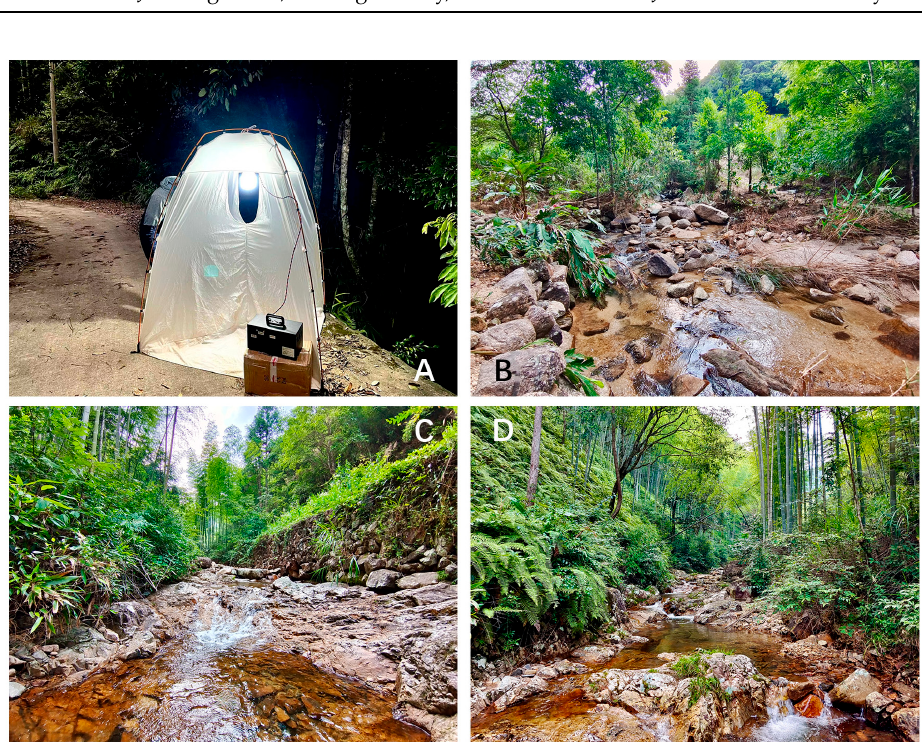
Figure 2. Photograph of a mobile light trap ( A ) and photographs of ecosystems ( B – D ): ( A ) light trap with mobile power and a high-pressure mercury lamp, in Hainan; ( B ) a tributary in Jianfengling National Forest Park, Hainan Province; ( C,D ) 62 the upper tributary of Dazhulan, Wuyishan National Park, Fujian (photographs by Haoming Zang and Lang Peng). 63